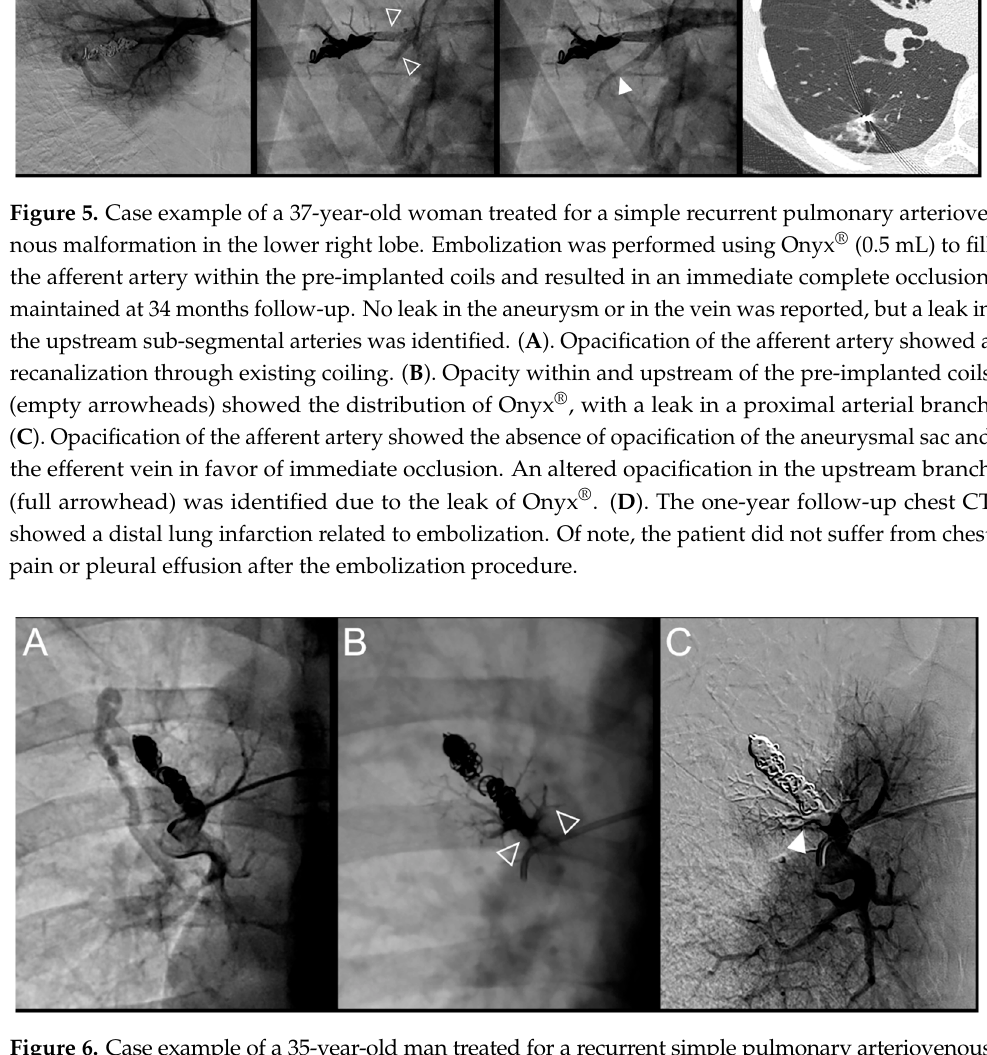
Figure 4. Case example of an 18-year-old man treated for a complex recurrent pulmonary arterio-